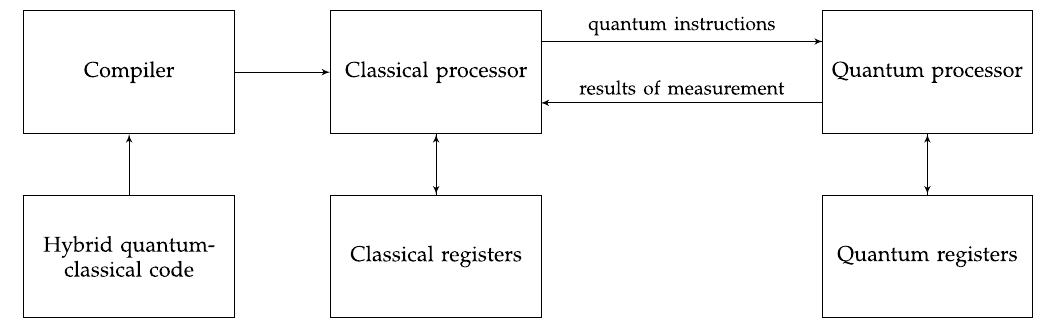
FIG. 3. Schematic description of the QRAM model. A hybrid code is compiled into the classical processor. The compiled code provides instructions to be performed by classical and quantum processors on their associated registers. The quantum processor sends the measurement results back to the classical